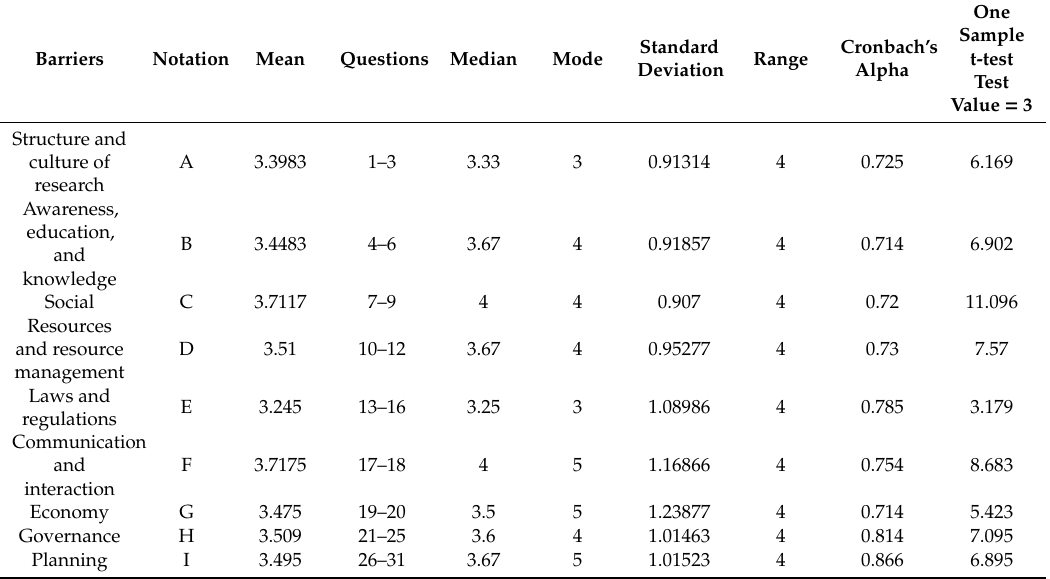
Table 2. Statistics of